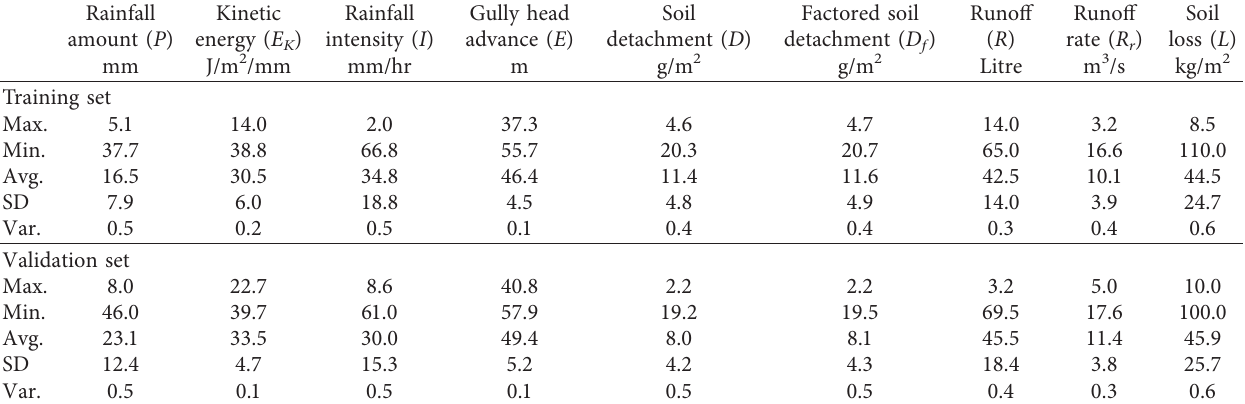
Table 3: Statistical analysis of collected database.